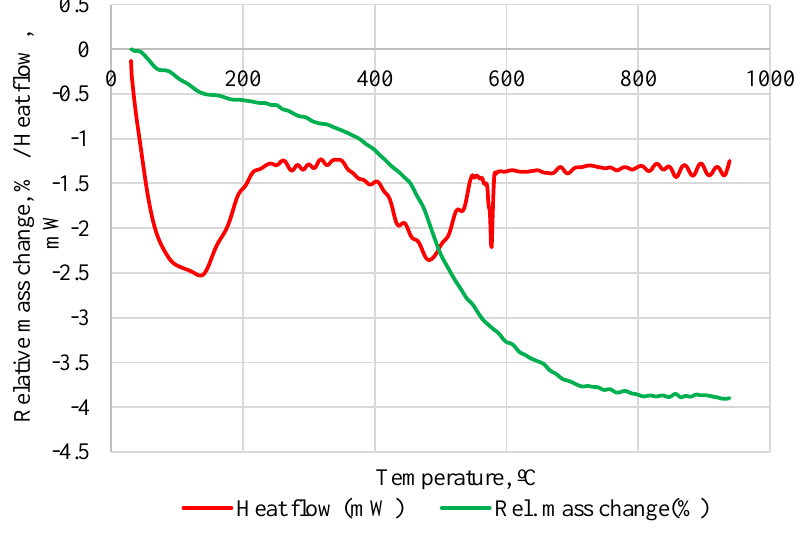
Figure 2. DTA/TG of raw IC.